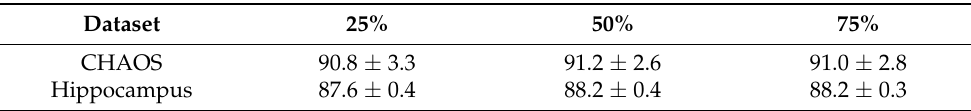
Table 8. Segmentation results for different numbers of subjects selected in our framework in DSC